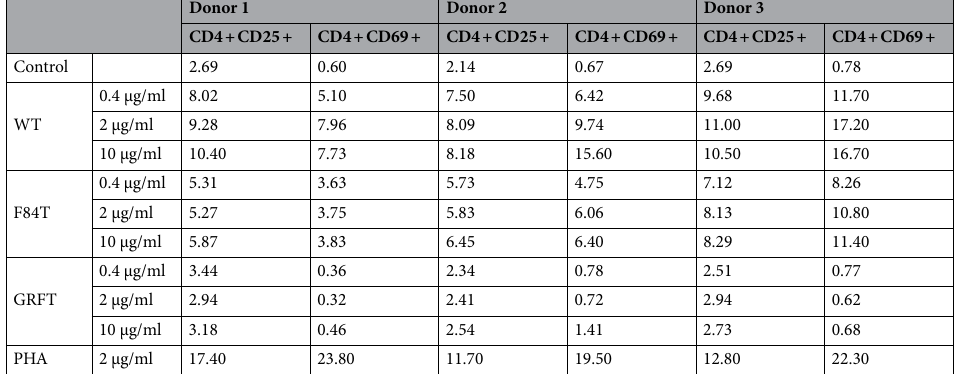
Table 1. Expression of cellular activation markers by F84T- versus WT-treated CD4 + PBMCs. The percent of cells positive for each marker is shown.